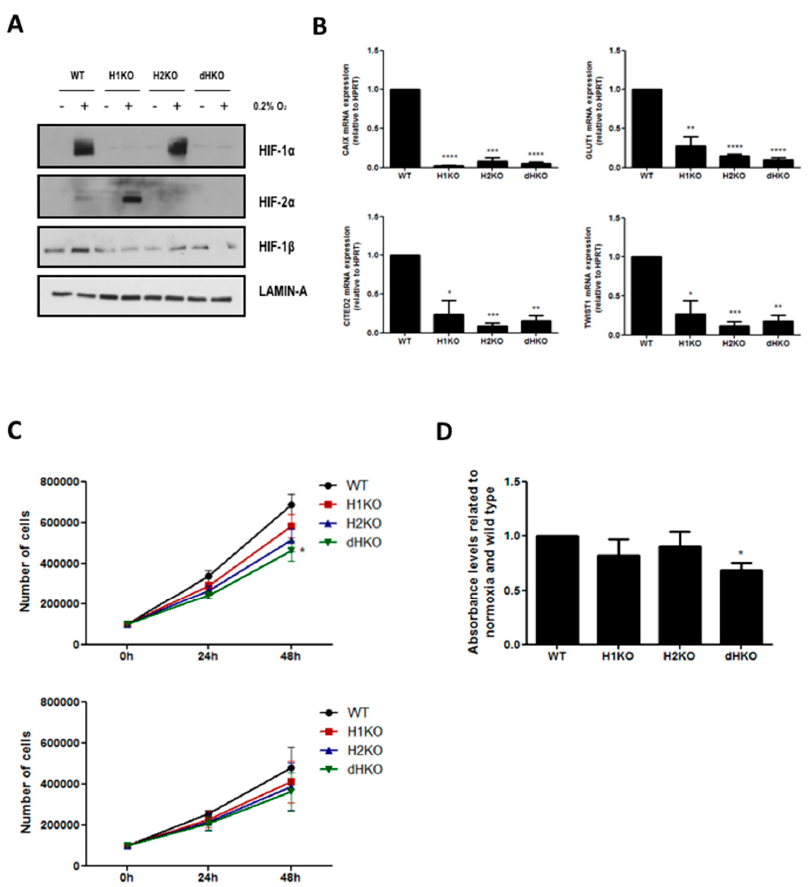
Figure 1. ( A ) Western blot of HIF-1 α , HIF-2 α and HIF-1 β expression in H1299 cells under